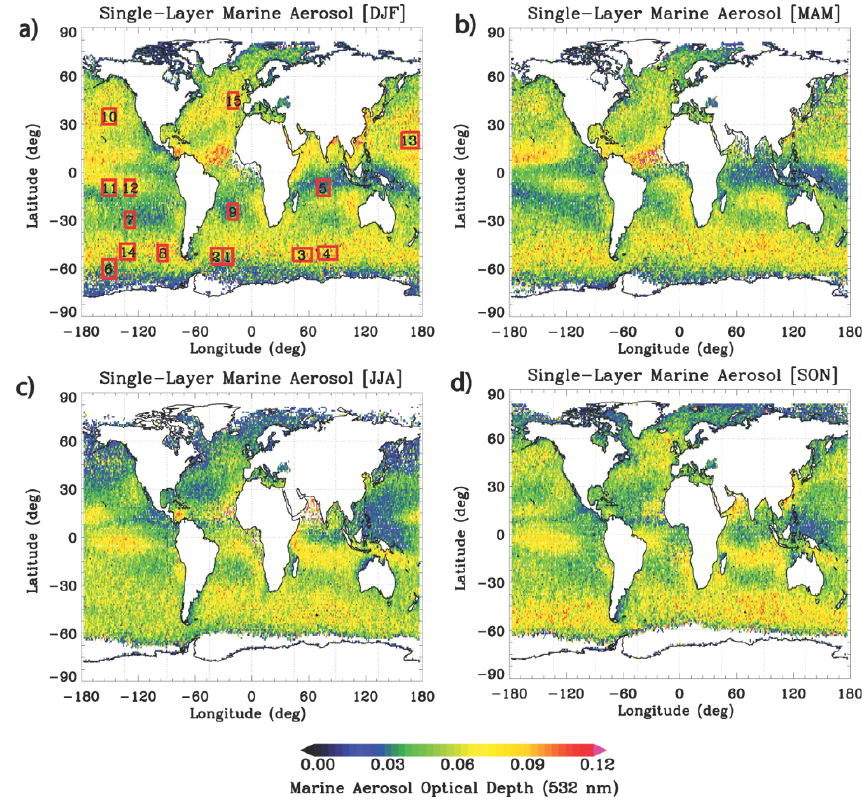
Fig. 1. Global distribution of 1 ◦ × 1 ◦ degree averaged CALIPSO level 2 version 3.01 mean AOD 532 for “clean marine” single-layer aerosols. Layer optical depths are averaged for boreal winter (DJF), spring (MAM), summer (JJA), and fall (SON) from June 2006 to April 2011. Areas surrounded by solid red line in Fig. 1a illustrate the regions selected for the detailed analysis. Latitudes and longitudes of the selected 15 regions are summarized in Table S1 in Supplement.